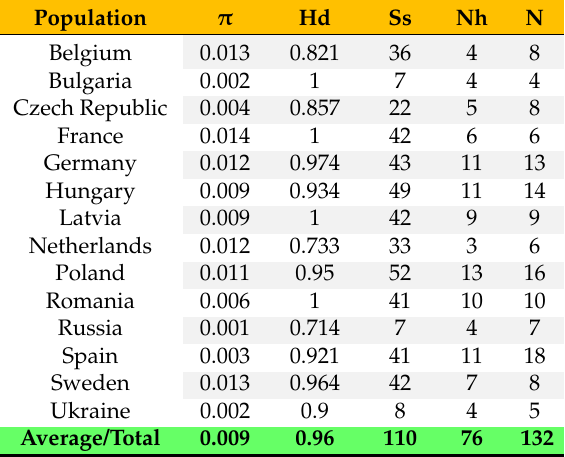
The table indicates: (1) π , nucleotide diversity, (2) Hd, haplotype diversity, (3) Ss, segregating sites, (4) Nh, number of haplotypes, and (5) N, number of